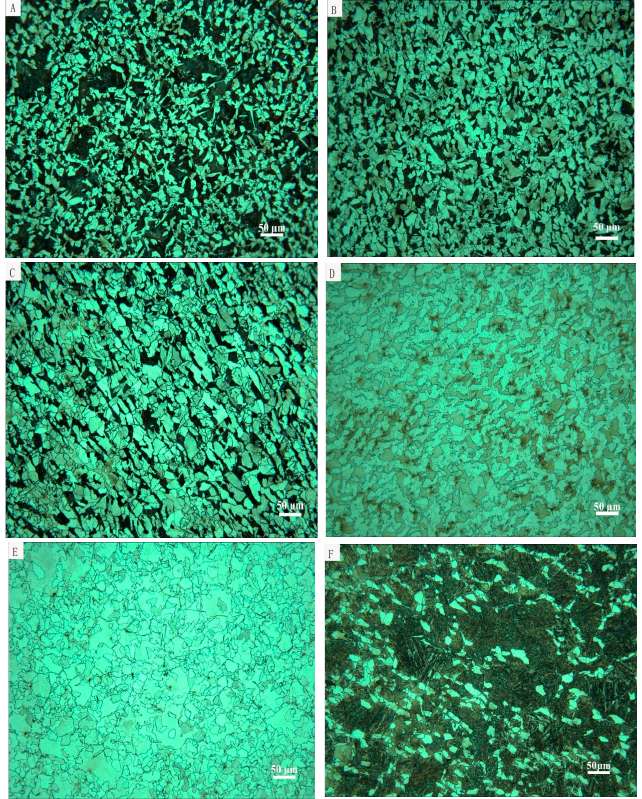
Figure 3. Microstructures of HRB500 steel samples with a holding time of 11 min at different tem- peratures ( A ): 600 °C, ( B ): 630 °C, ( C ): 650 °C, ( D ): 680 °C, ( E ): 700 °C, ( F ): 730 °C.